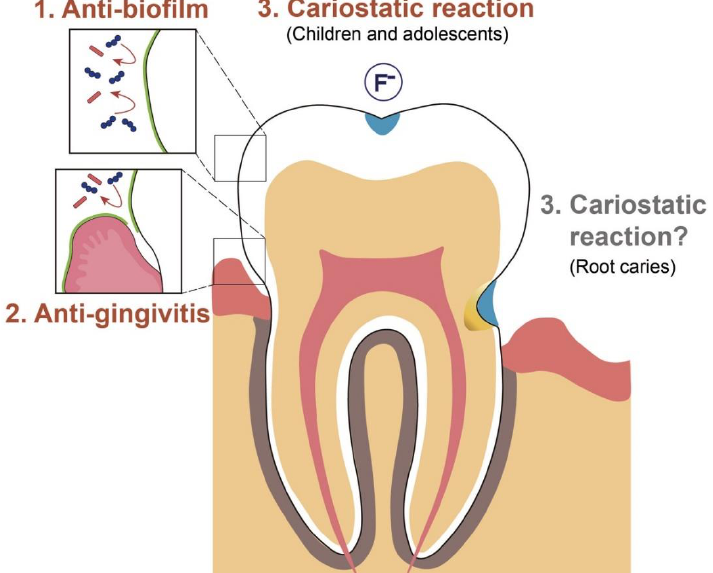
Figure 4. Schematic diagram of the clinical effects of mouthwashes against supragingival dental biofilm with strong evidence. The anti-biofilm property (1) has been proven to be effective, followed by the anti-gingivitis property (2), and their cariostatic actions are aimed at children and adolescents (3). There are no conclusive findings regarding the preventive effect of fluoride mouthwash alone on root caries.